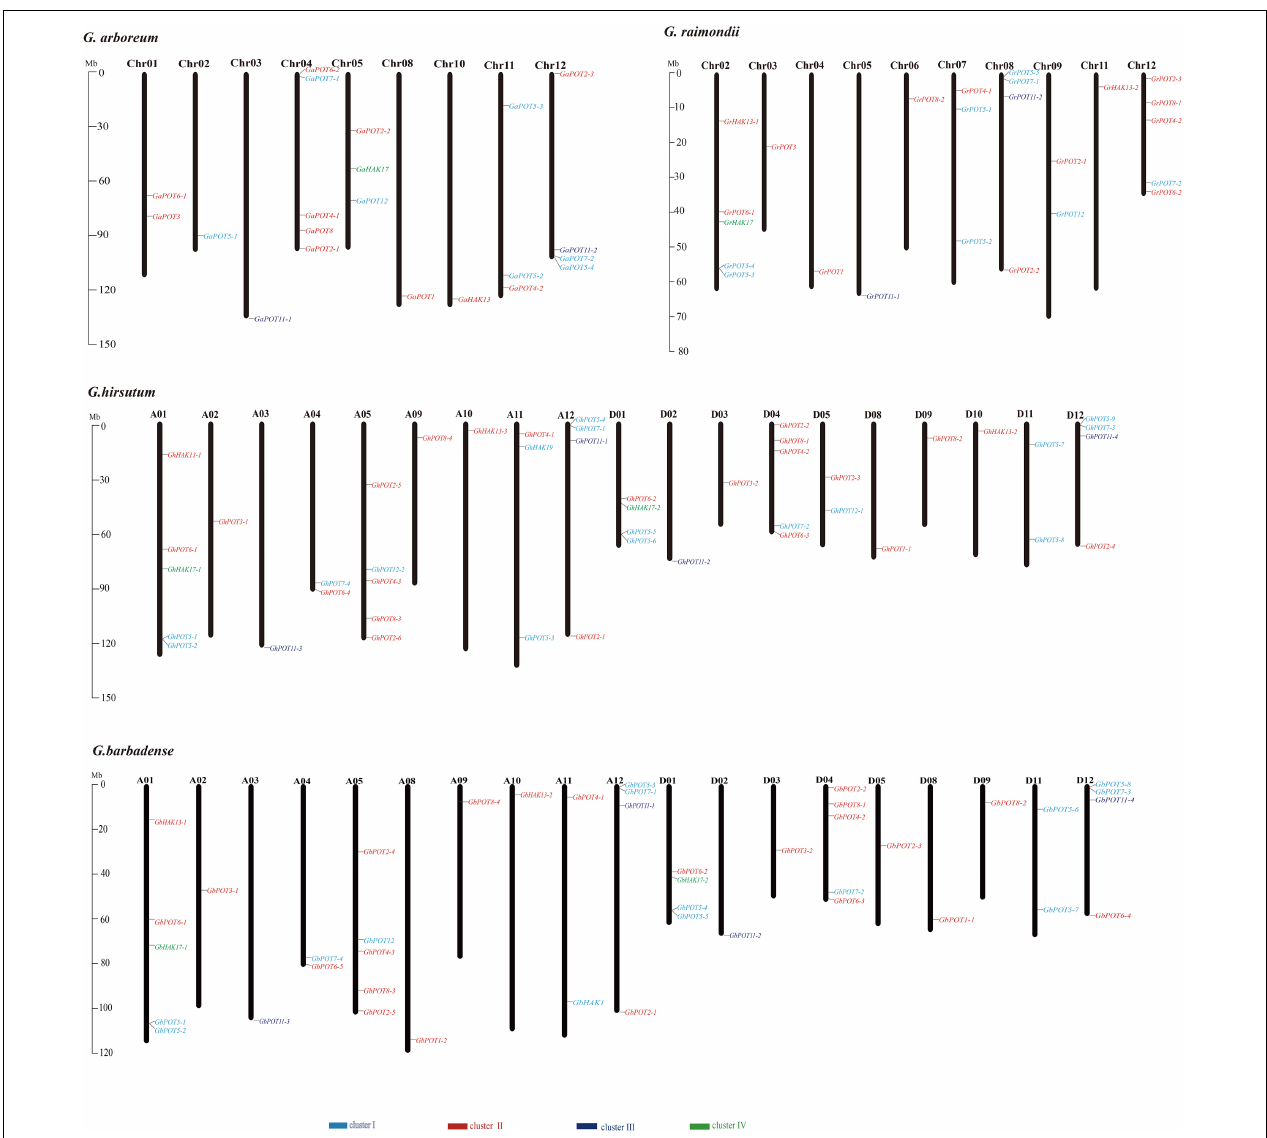
FIGURE 3 | Chromosomal distributions of HAK/KUP/KT genes in G. arboreum , G. raimondii , G. hirsutum, and G. barbadense . The chromosome number is indicated above each vertical bar representing one chromosome. The gene names are indicated on the right side. The HAK/KUP/KTs in each cluster are shown in the same color. The lengths of the chromosomes are shown in Mb (millions of